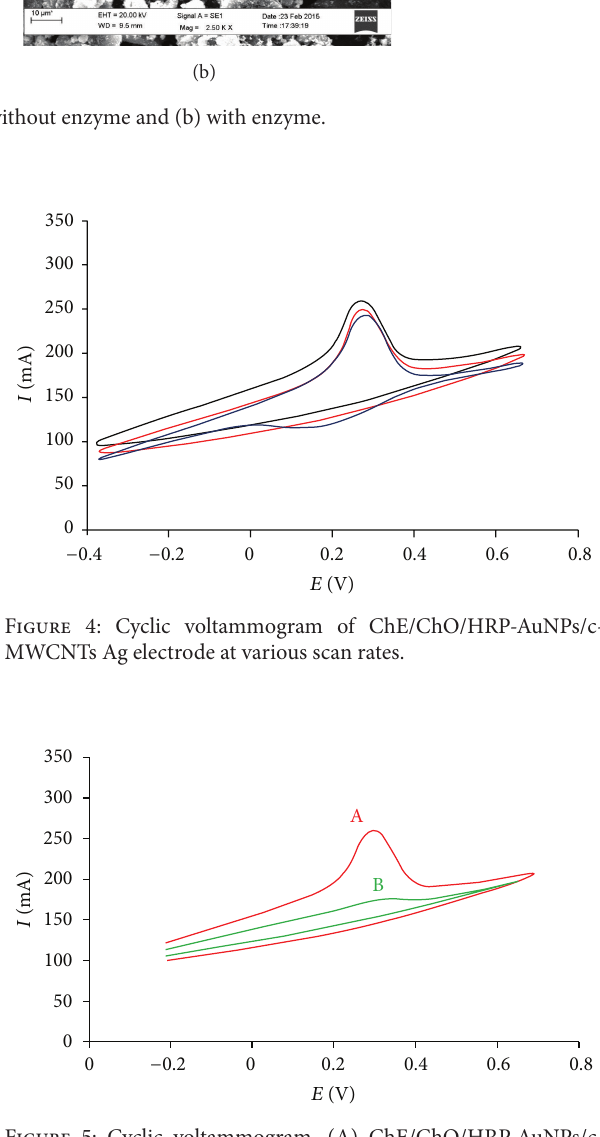
Figure 5: Cyclic voltammogram. (A) ChE/ChO/HRP-AuNPs/c- MWCNTs; (B) bare silver